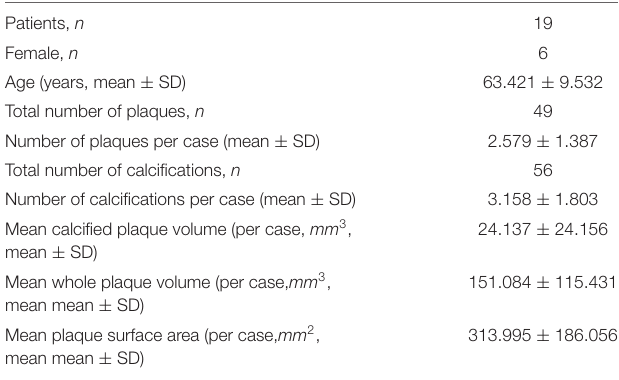
TABLE 2 | Characteristics of